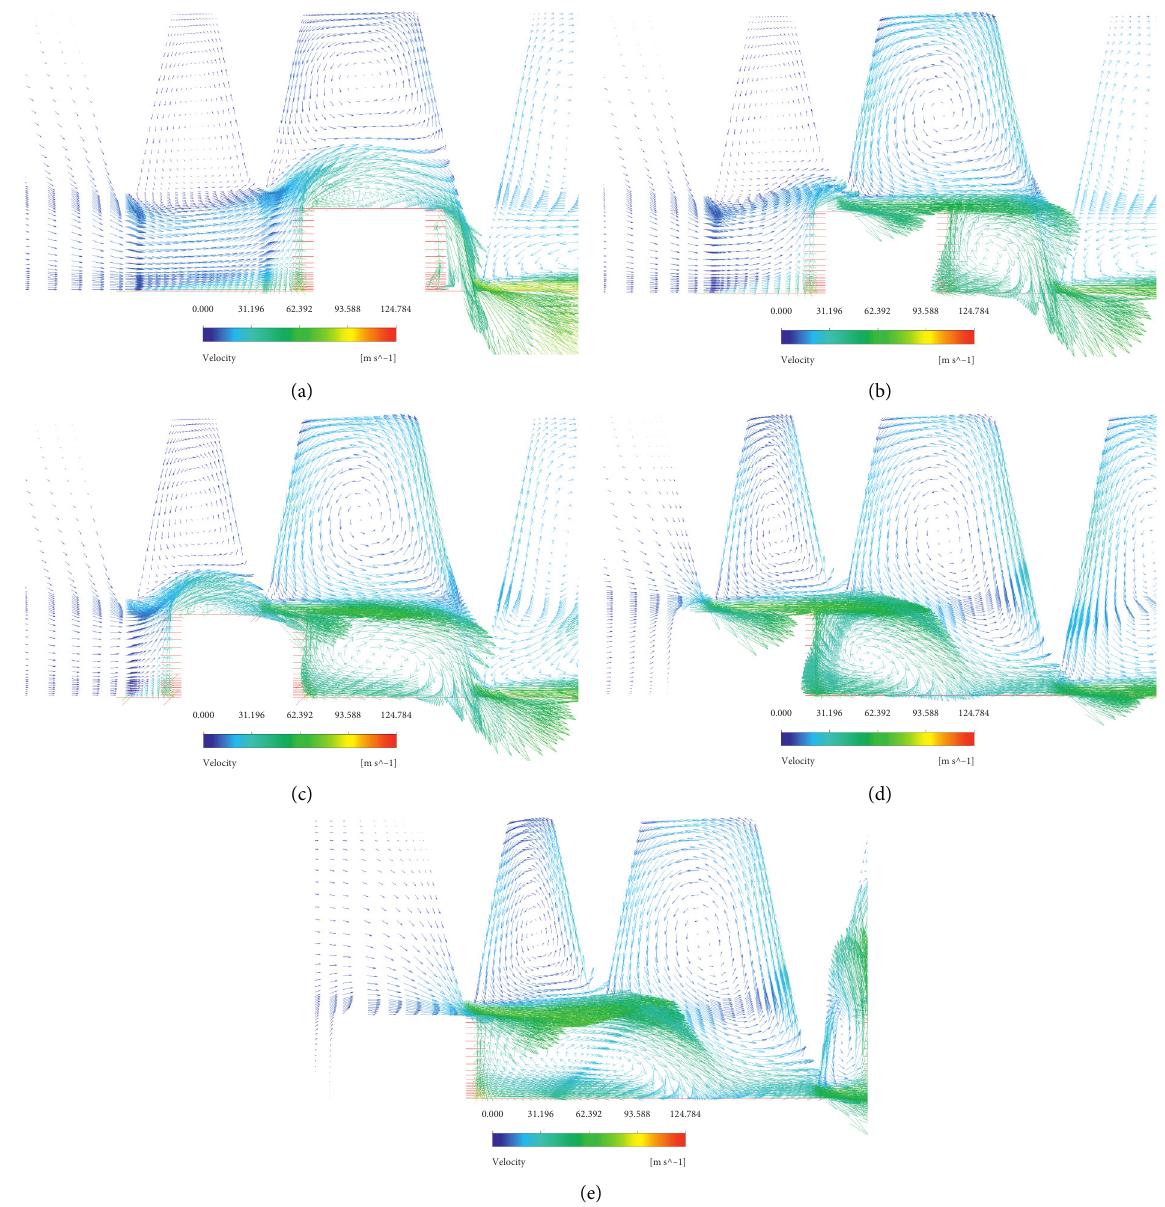
Figure 7: Velocity vector with a different rotor axial shifting. (a) z � -4mm, (b) z � -2mm, (c) z � 0mm, (d) z � +2mm, and (e) z �